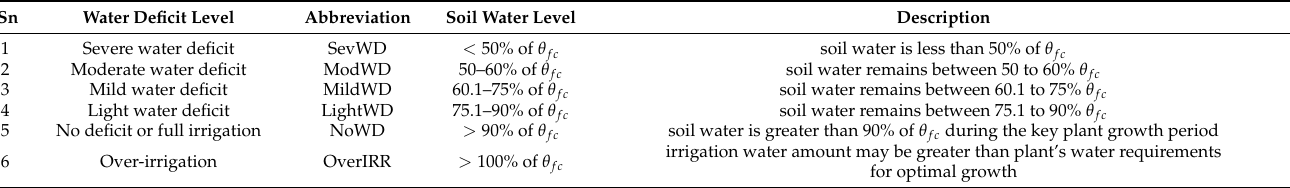
Table 2. The water deficit levels depending on soil water